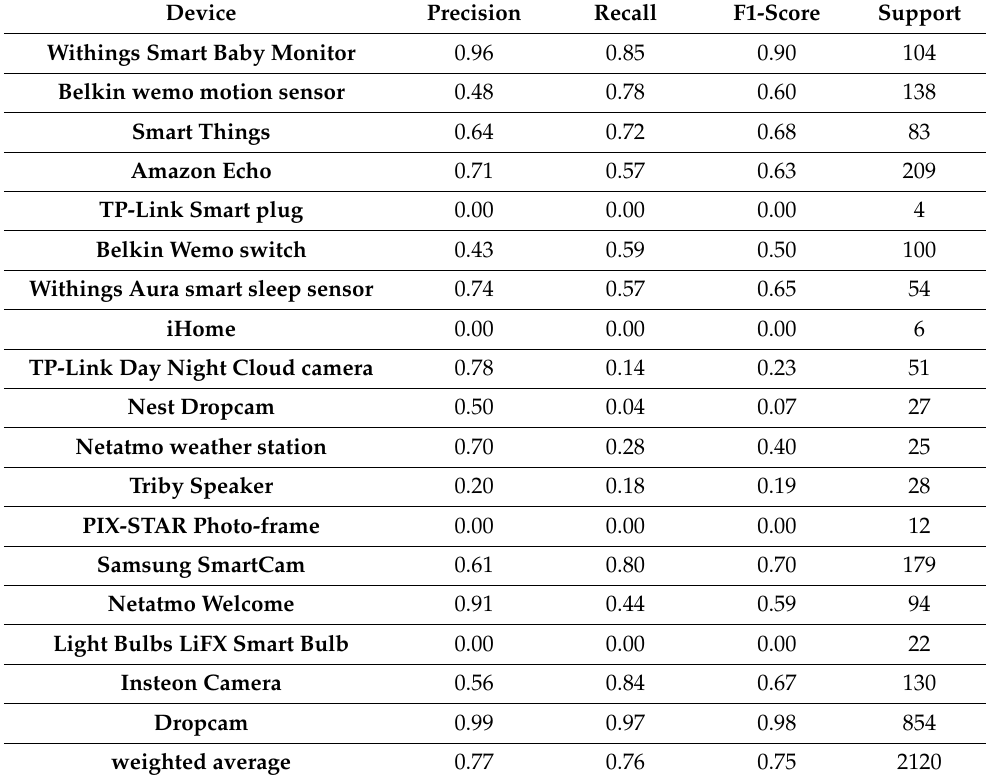
Table 9. The precision, recall, and F1-score results and the numbers of test data for the MLP.